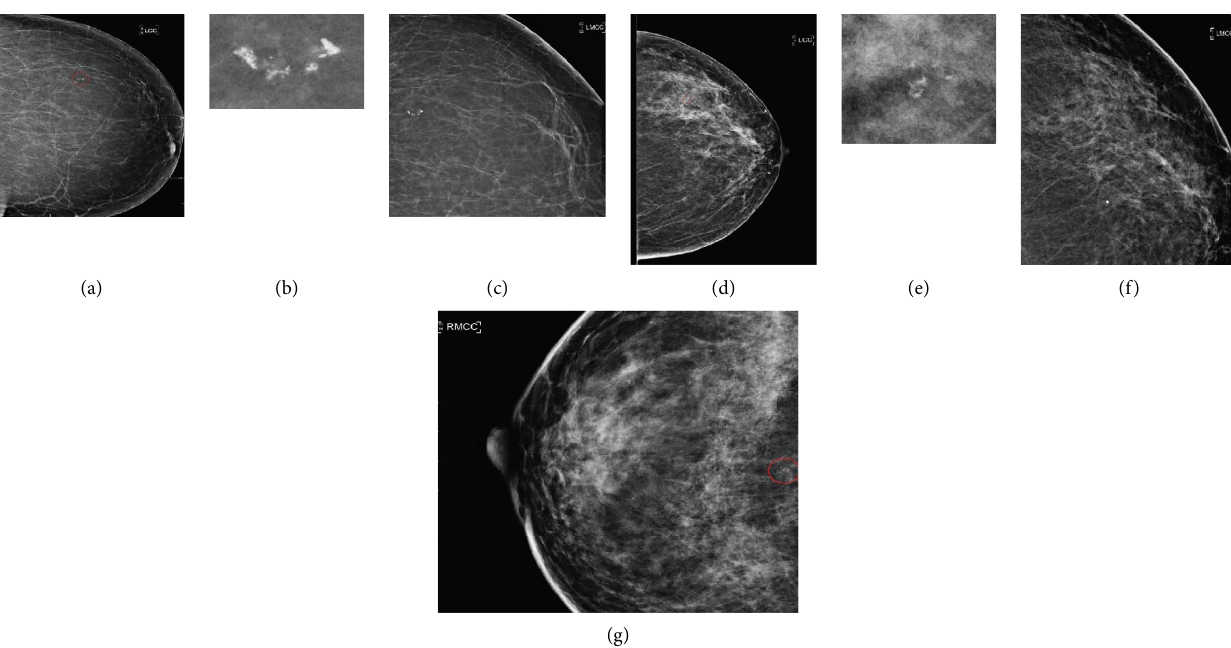
Figure 2: Radiographic fndings. Representative radiographs from case of LCIS upgraded to invasive carcinoma at surgical excision. All calcifcations in these cases were defned as “coarse and heterogenous,” which are by defnition a BI-RADS 4B lesion and thus have a 10–50% risk of malignancy. Tere is no radiological fnding that can reliably diferentiate LCIS from more invasive carcinoma. (a) Screening mammogram in case 1. Grouped calcifcation in the middle 3rd of the upper-outer left breast. (b) Magnifed image of calcifcations from screening mammogram of case 1. (c) Diagnostic mammogram confrming the fndings in screening mammogram (case 1). (d) Screening mammogram in case 2. Tere appear to be grouped developing calcifcations in the middle 3rd of the upper-outer left breast. (e) Magnifed image of calcifcations from screening mammogram of case 2. (f) Diagnostic mammogram confrming the fndings in screening mammogram (described as grouped coarse heterogeneous calcifcations (case 3)). (g) Diagnostic mammogram performed for high-risk screening. Grouped calcifcations are seen in the retroareolar right breast, in the anterior to middle 3rd depth (case